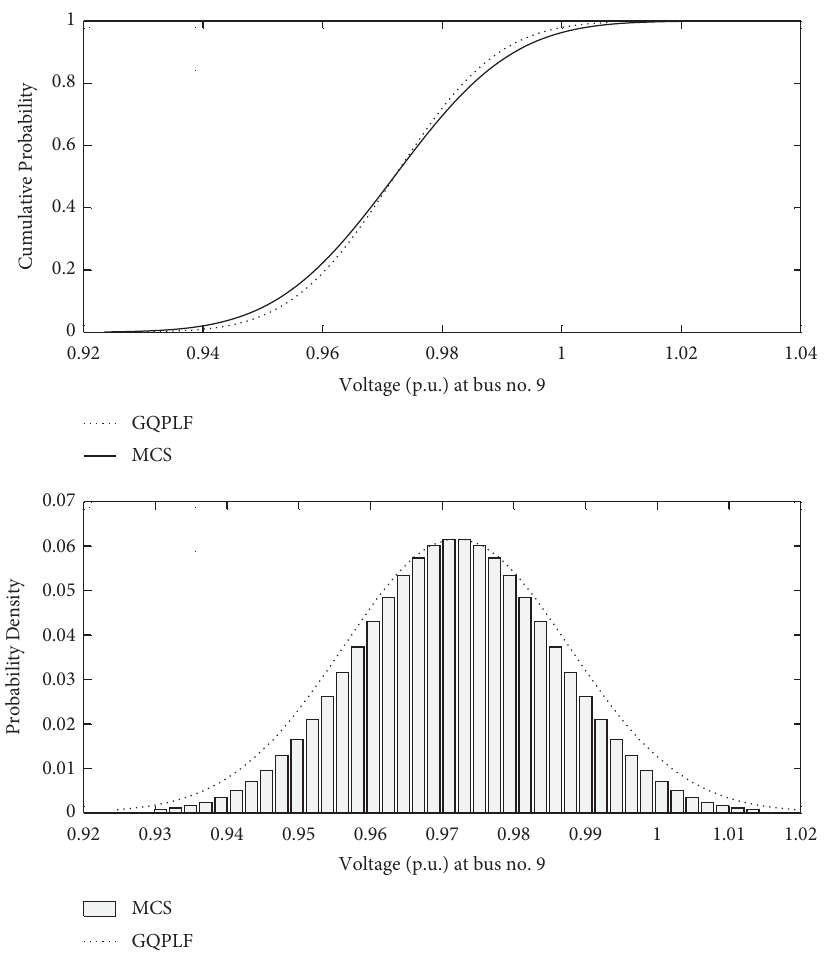
Figure 4: Distributions of voltage at bus no.